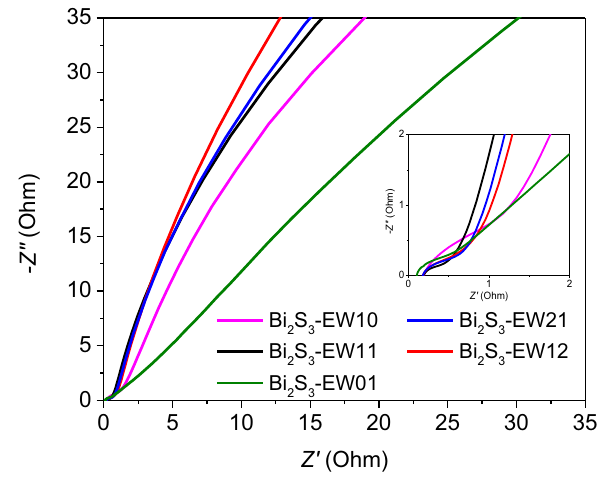
Fig. 7 Impedance spectroscopy plots of various bismuth